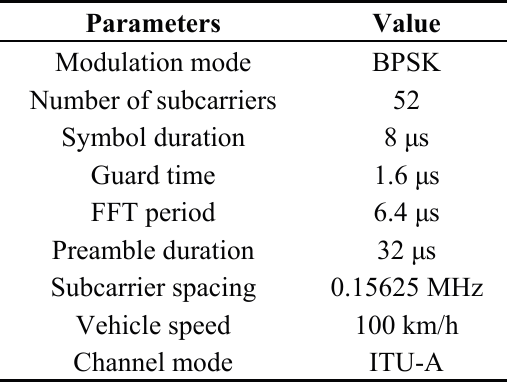
Figure 12. | P ( d )| 2 , R 2 ( d ) and M ( d ) of SC-80 method in ideal environment. Table 1. Parameters for the